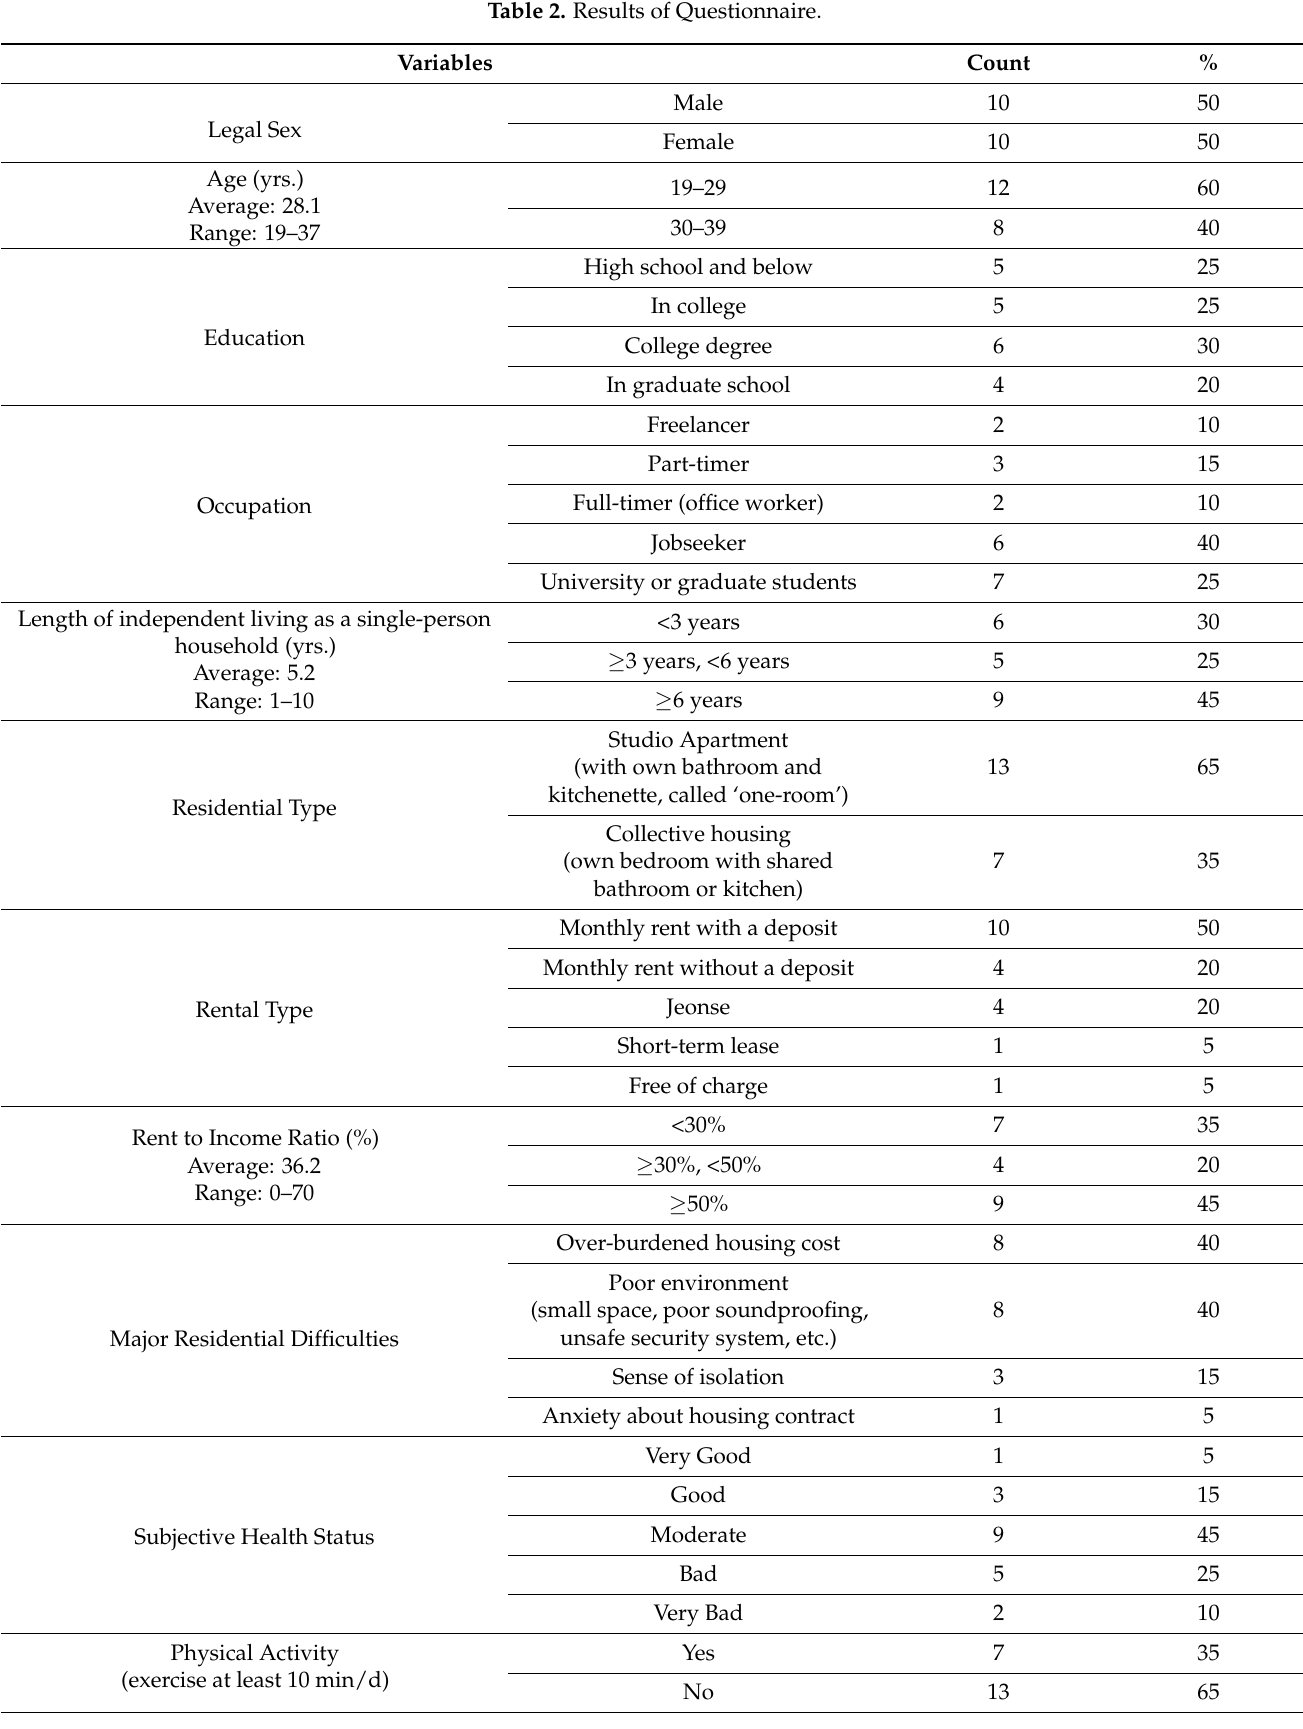
Table 2. Results of